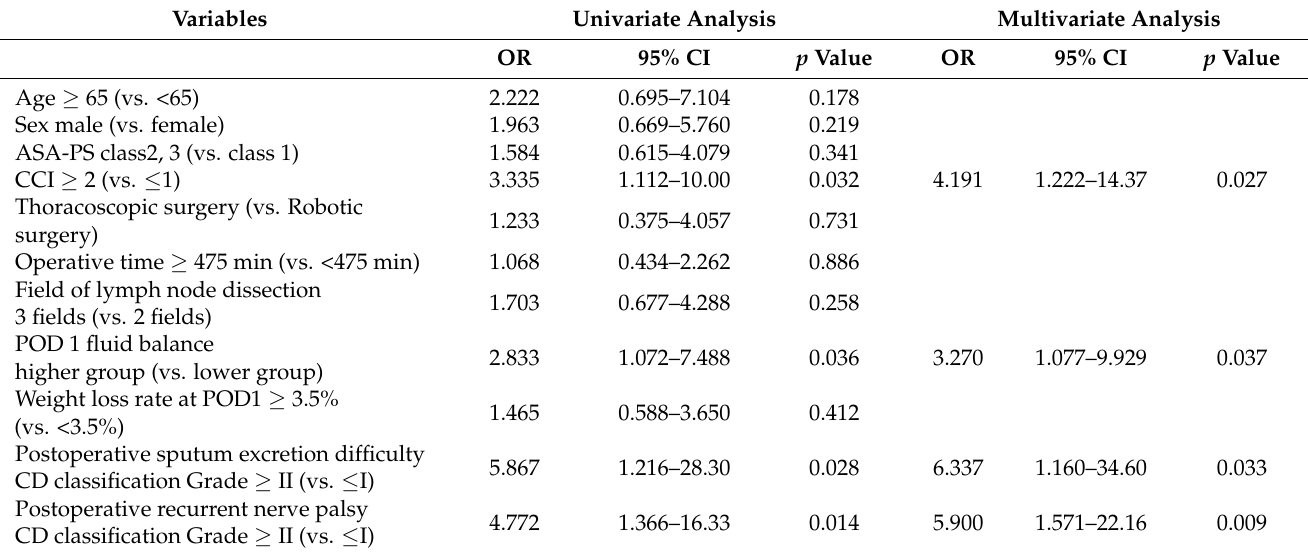
Table 5. Factors associated with acute pneumonia after surgery by univariate and multivariate analyses.